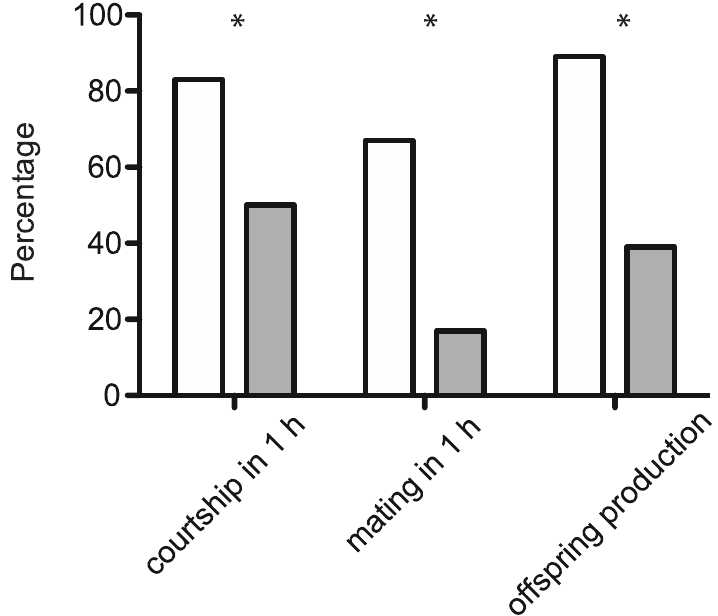
Figure 4. Courtship, mating and reproductive output of D. suzukii males with (white bars) or without (grey bars) antennae. Individual 4-d-old male-female couples ( n = 18) were observed for one hour in the morning (starting within 30 min after lights went on). Afterwards the couples were kept together for two weeks and production of offspring was recorded. The asterisks indicate a significant decrease in courtship and mating rates as well as reduced reproductive output after antennal ablation (LR χ 2 , p <